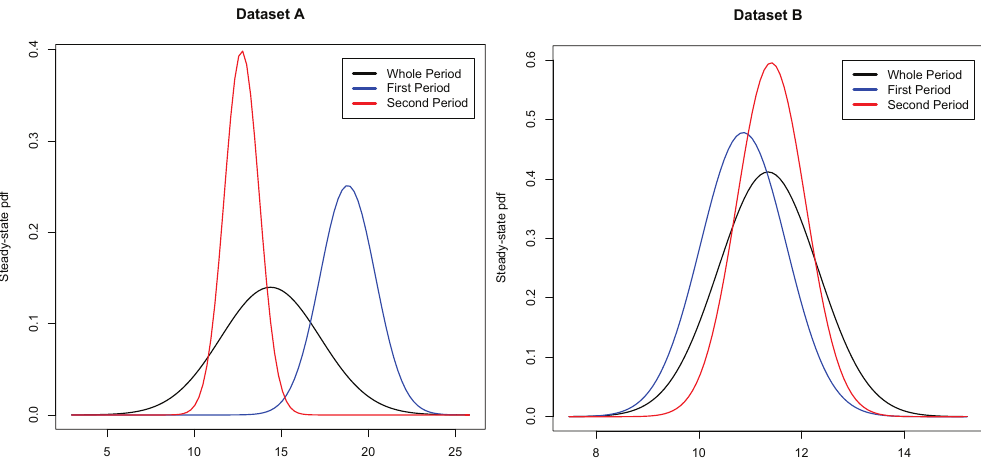
Figure 2. The Vasicek steady-state densities for Datasets A (on the left ) and B (on the right ) evaluated by using θ given in Table 1 for the whole period: 1 July 1997–31 March 2015 and by using the parameters given in Table 2 for the sub-intervals identified by the Chow